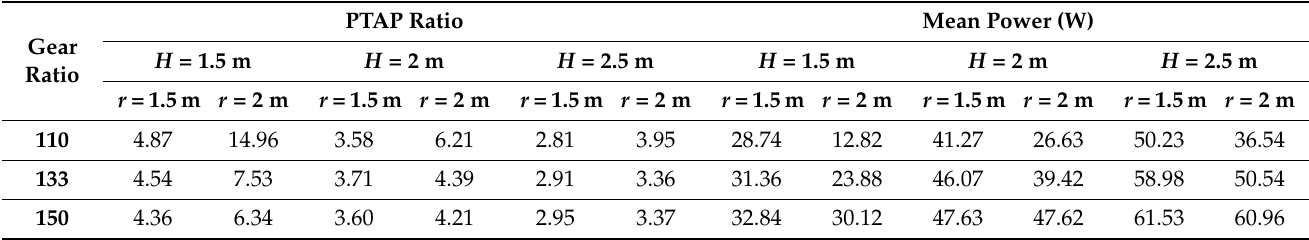
Table 6. PTAP ratio and mean power for a regular wave with a fixed-wave period ( T = 11 s). Gear Ratio